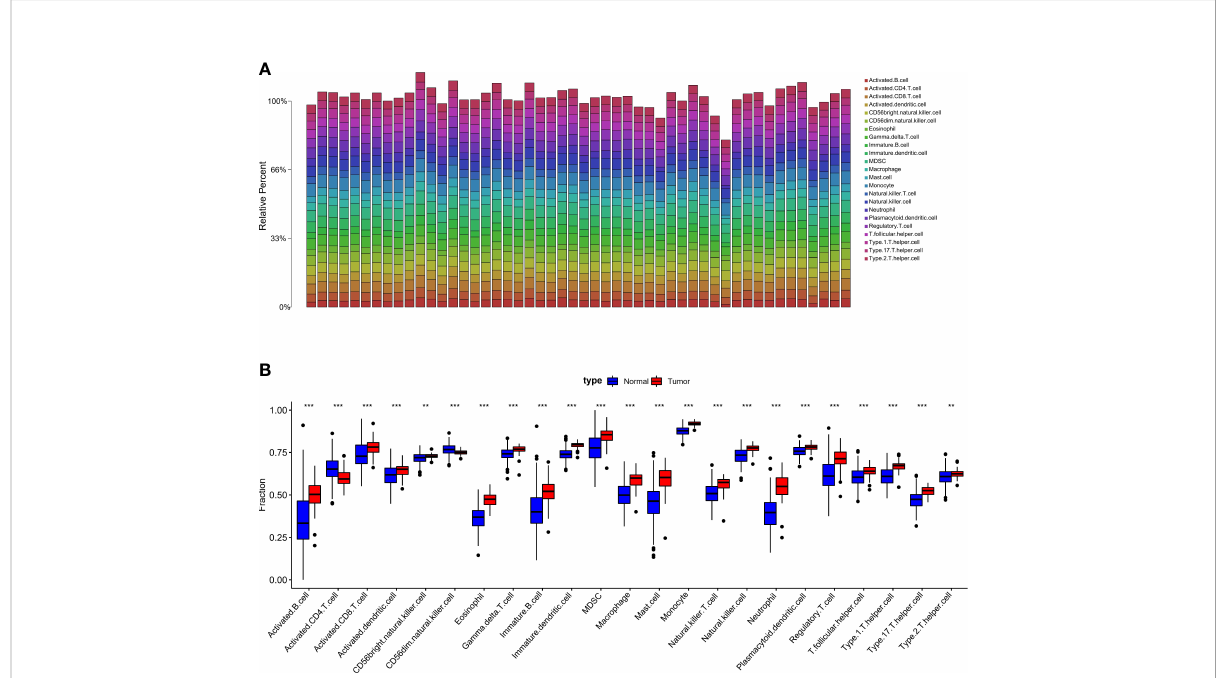
FIGURE 2 Comparison of immuno-cell in fi ltration in tumor and adjacent non-tumor sectin (A) . Heat map showed the tissue in fi ltration ratio of 23 immuno-cells in each paracancerous tissue sample (B) . Box plot statistics show the difference regarding the in fi ltration ratio of each immune cell in HCC samples and adjacent tissue samples (**p < .01,***p <